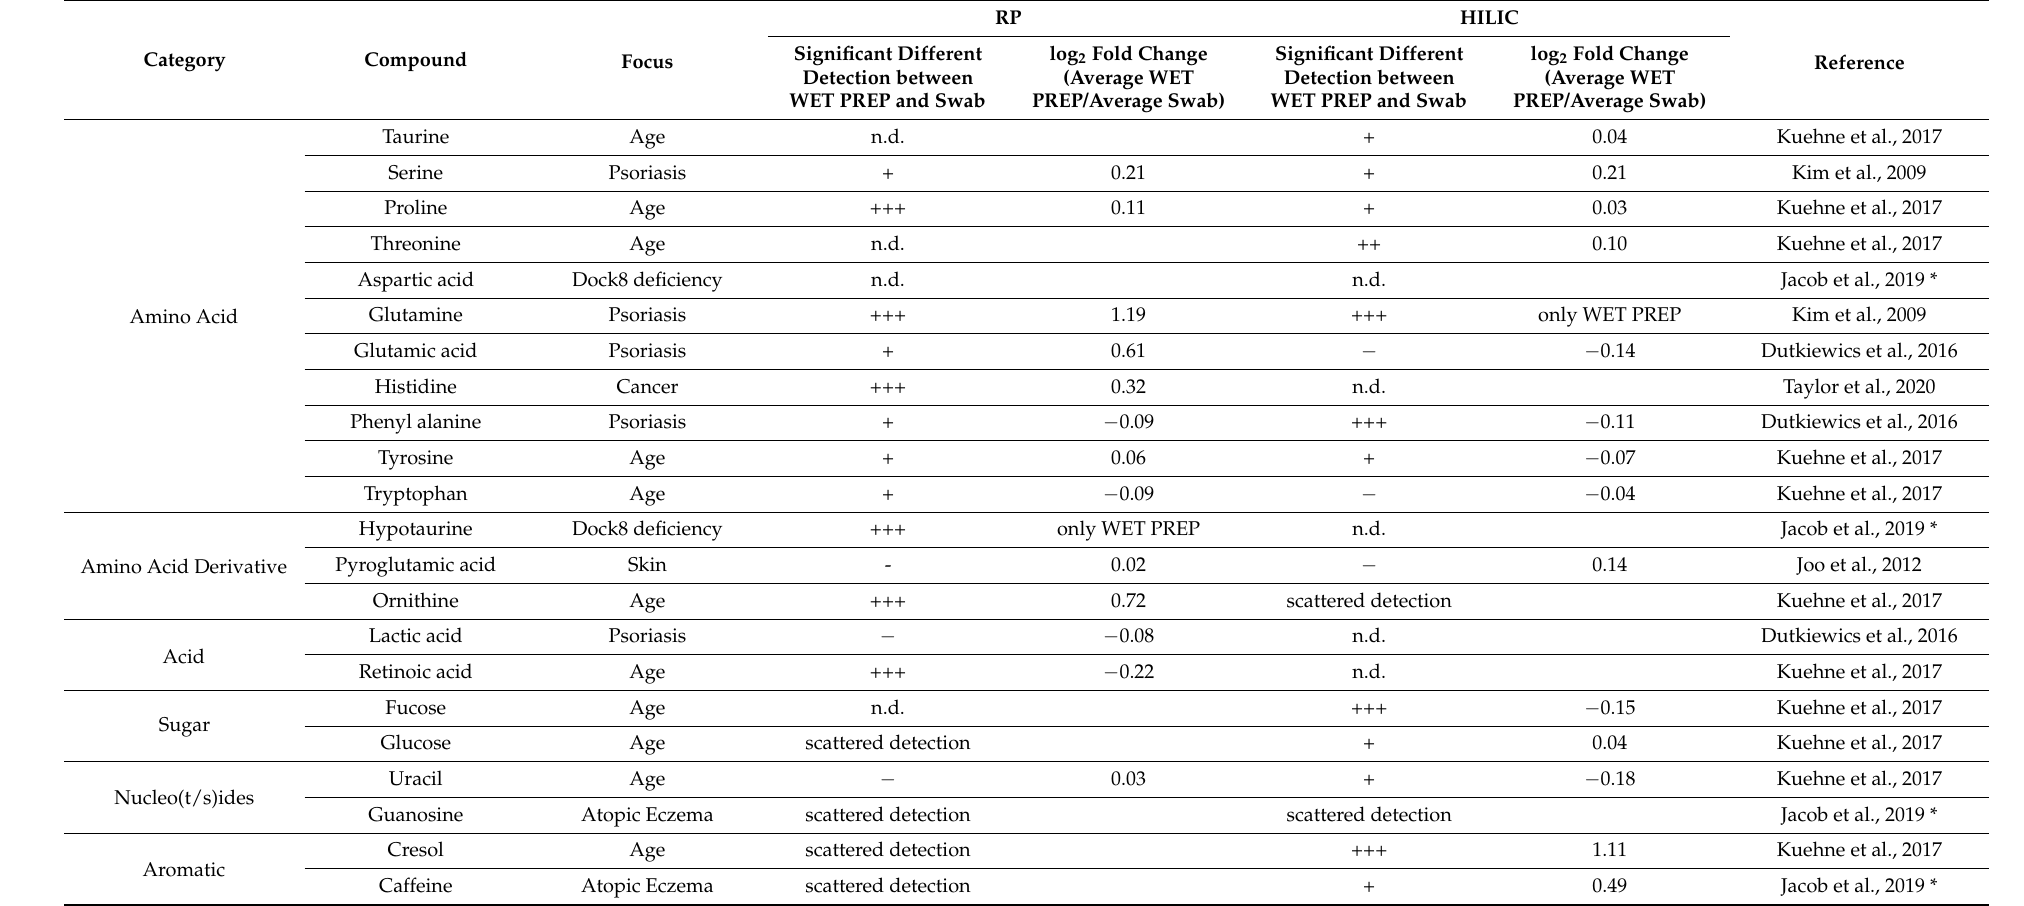
Table 1. Metabolites of skin relevance. Compounds of interest were compared for their detection in swabs and WET PREP samples. Exact m / z values (0.005 Da) and retention time were used for identification. All compound identification was verified with analytical standards. Log2 fold change WET PREP/swab of the average intensities across all samples are shown. (n.d.) denotes that the compound is not detected. Metabolites are grouped according to chemical type with their references as seen on the far right. (*) denotes a reference from a serum study. Samples were tested for significance by Welch test: p < 0.05 (+), p < 0.005 (++), p < 0.0005 (+++). Scattered detection indicates partial detection in only some of the